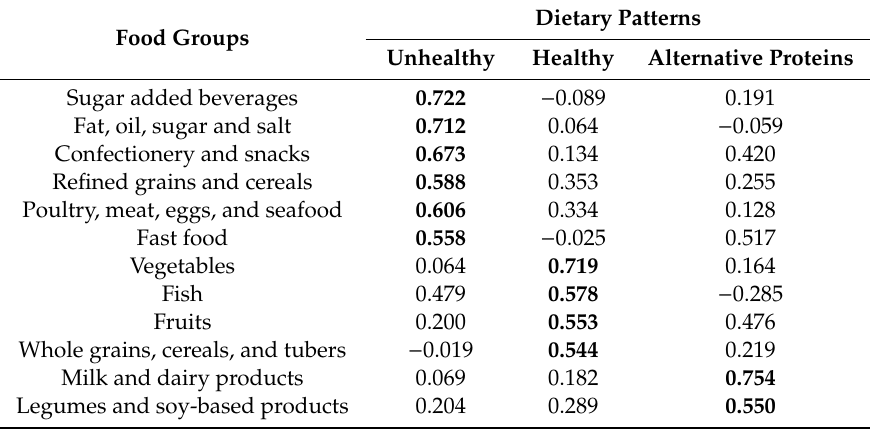
Table 4. List of factor-loading of dietary